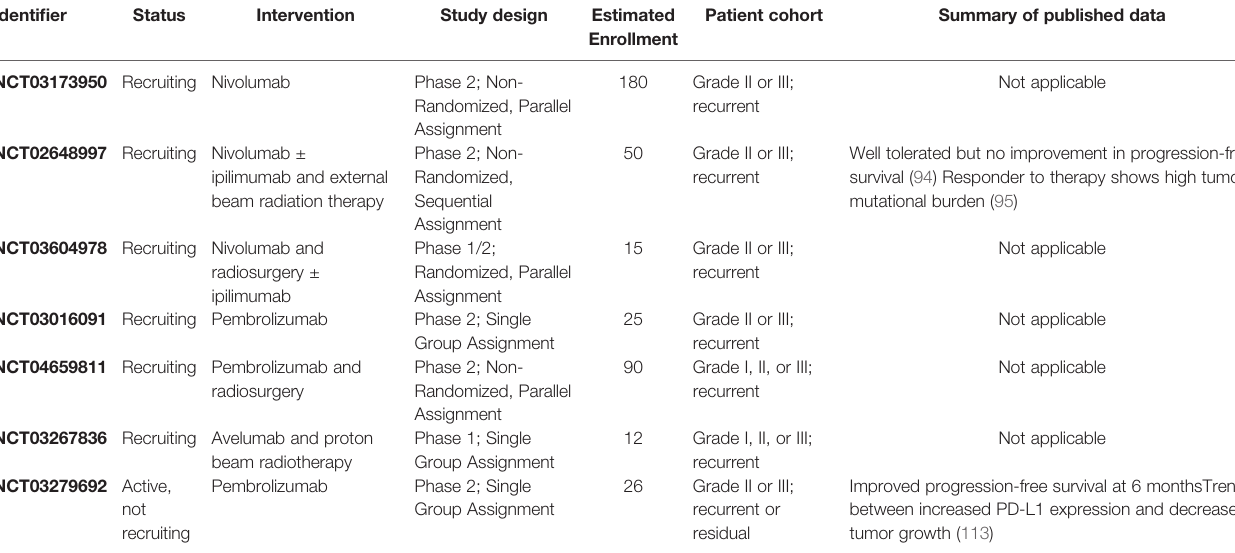
TABLE 1 | Active clinical trials assessing immunotherapy for meningiomas registered on